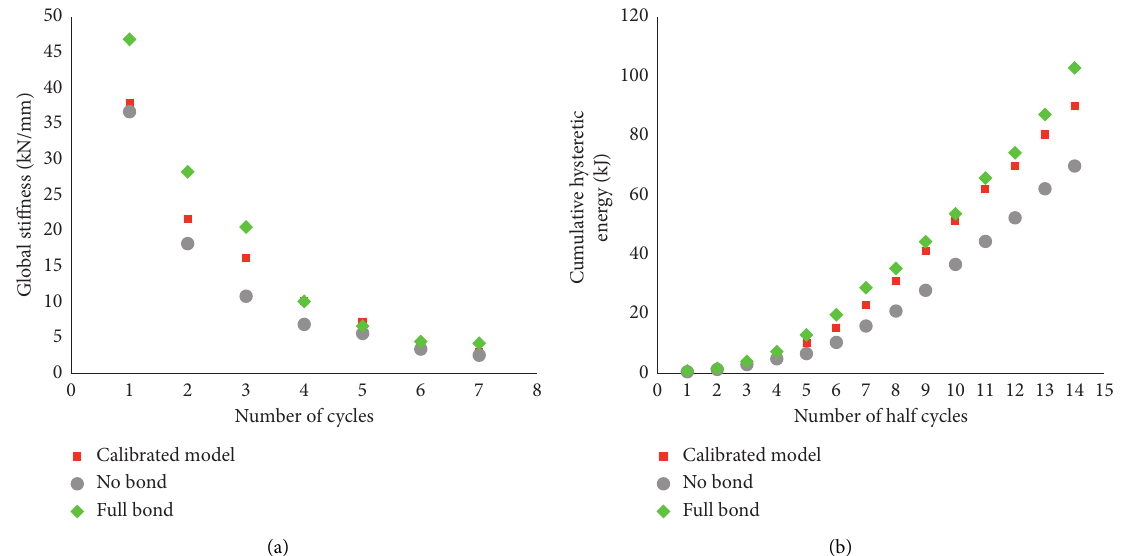
Figure 12: Comparison of the results in terms of (a) stiffness and (b) hysteric energy between the numerical model results considering full bond, no bond, and calibrated model bond conditions.